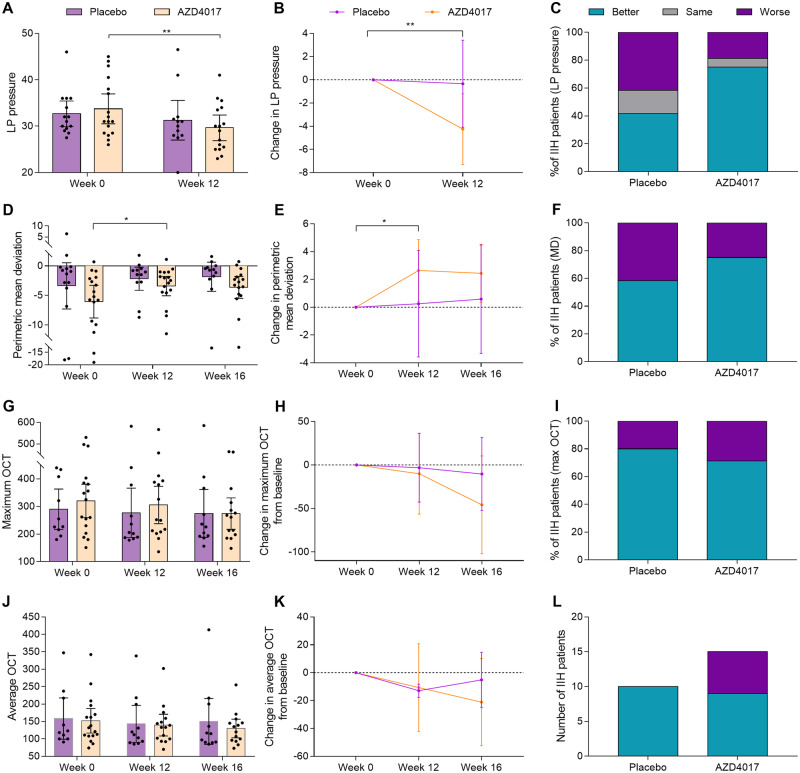

Clinical outcomes following treatment with AZD4017 and placebo for 12 weeks and then 4 weeks after stopping treatment. (A) Absolute LP pressure. (B) Change in LP pressure. (C) Percentage of patients with better, same or worse LP pressure at 12 weeks. (D) Absolute visual field mean deviation (dB). (E) Change in visual field mean deviation. (F) Percentage of patients with better, same or worse visual field mean deviation at 12 weeks. (G) Absolute maximum OCT RNFL height (µm). (H) Change in maximum OCT RNFL height. (I) Percentage of patients with better, same or worse maximum OCT RNFL height at 12 weeks. (J) Average OCT RNFL height (µm). (K) Change in average OCT RNFL height. (L) Number of patients with better, same or worse average OCT RNFL height at 12 weeks. The number of OCT scans performed varied during the conduct of the trial due to patients declining this aspect of the protocol and due to times when the scanner was not operating. Data are presented as mean ± 95% confidence index. *<0.05, **<0.01. LP = lumbar puncture, OCT = optical coherence tomography, RNFL = retinal nerve fibre layer